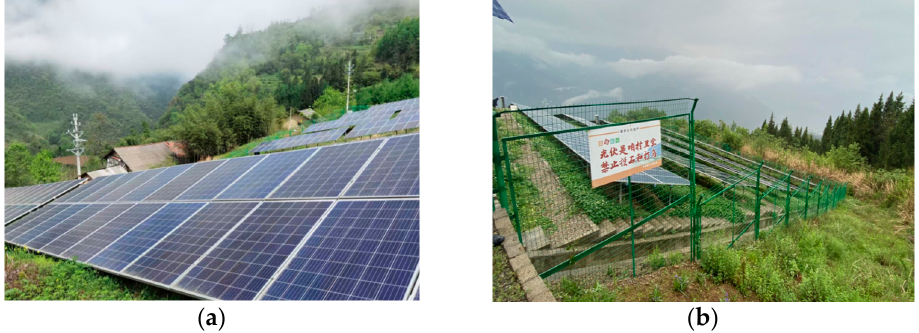
Figure 1. Photoshoots of the PV power station at Songjialiangzi village, Hubei province, China: ( a ) front view ( b ) side view.